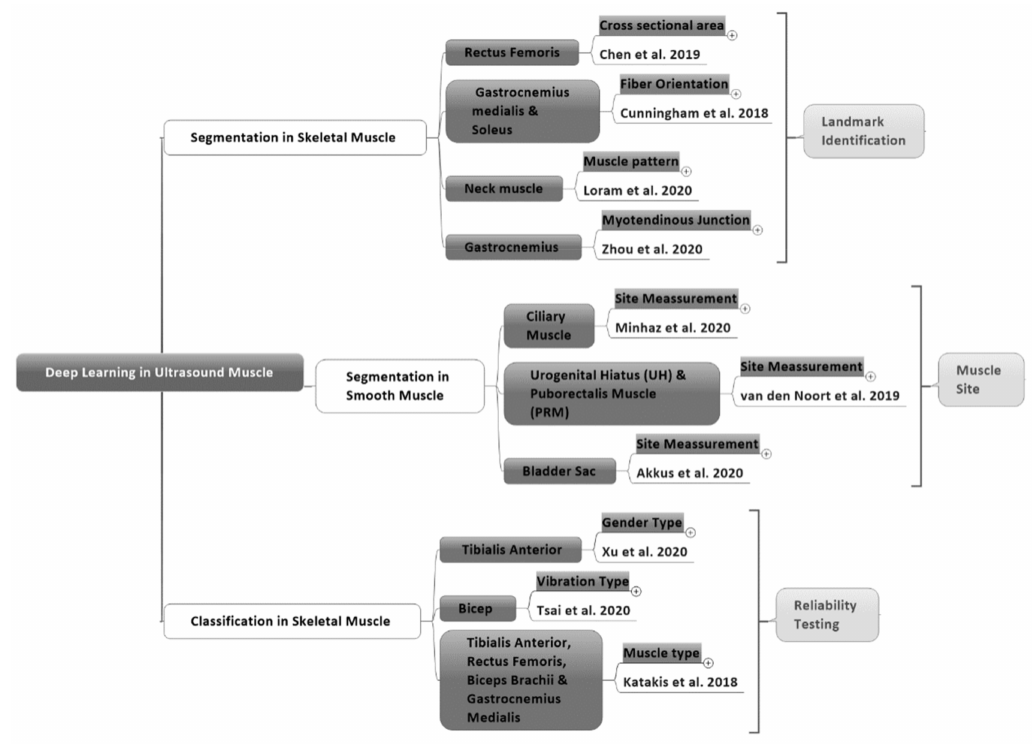
Figure 1. The purposes of deep learning in studies of skeletal and smooth muscle areas from